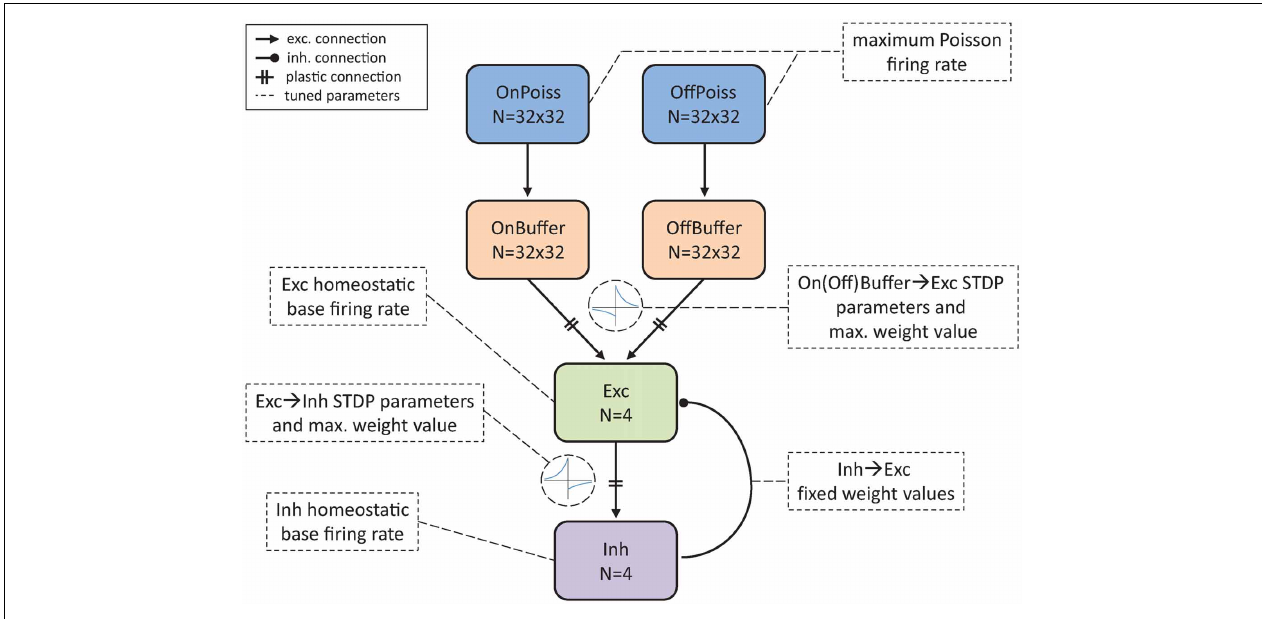
FIGURE 3 | Network architecture of the SNN tuned by the parameter tuning framework to produce V1 simple cell response and SORFs. N represents the number of neurons used in different groups. E → E and E → I